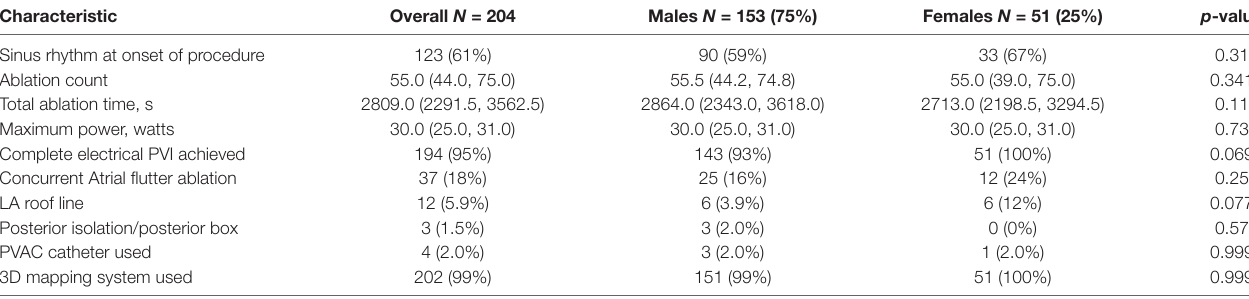
TABLE 2 | Catheter ablation procedure details for the overall cohort and stratified by sex. Characteristic